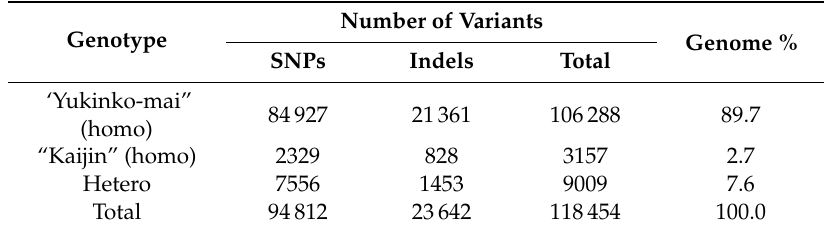
Table 1. Single nucleotide polymorphism (SNP) / indel detection in BC 3 F 2 #31-2-4. SNPs / indels in BC 3 F 2 #31-2-4 are classified into “Yukinko-mai”-type (homo[zygous]), “Kaijin”-type (homo(zygous)), and Hetero(zygous)